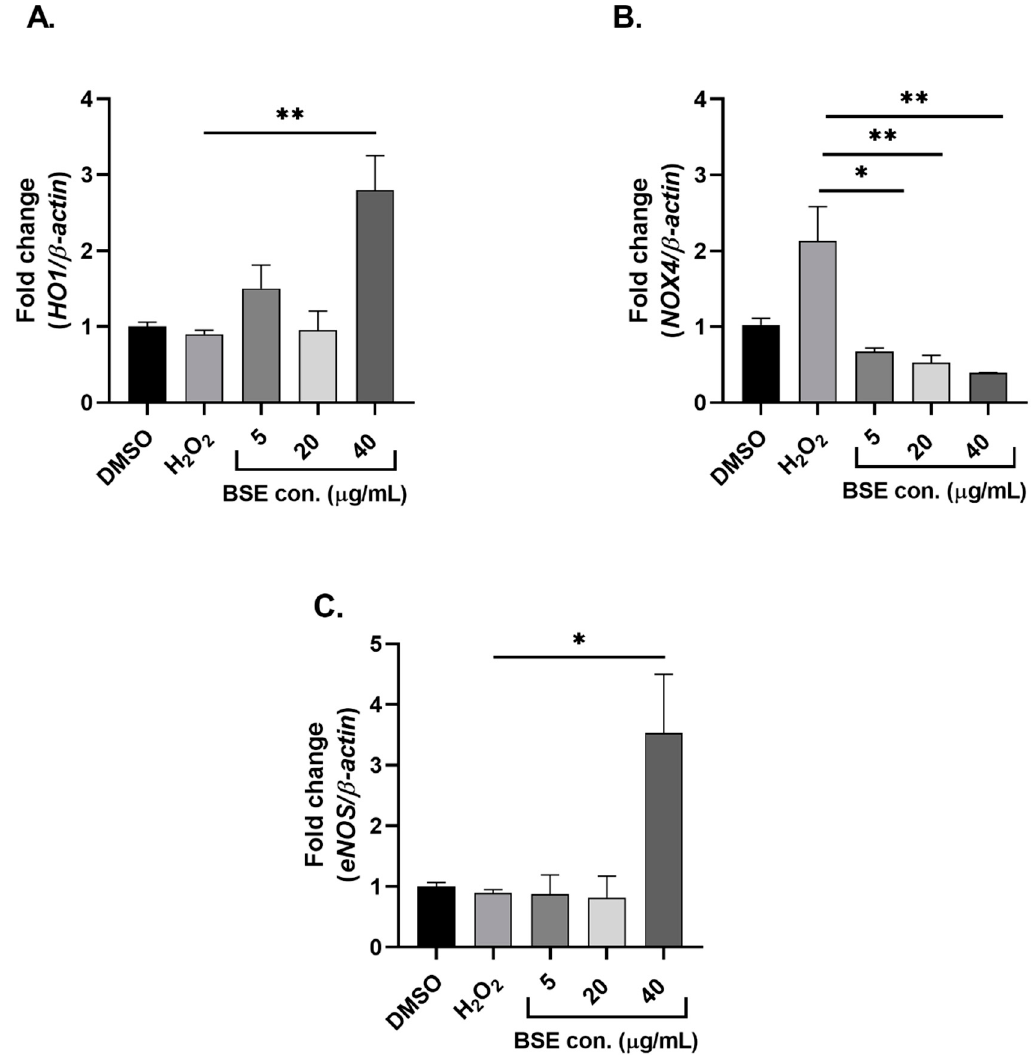
Figure 2. Changes in the expression profile of antioxidant genes [ HO1 ( A ), NOX4 ( B ) and eNOS ( C )] with BSE pre-treatment on oxidative stress-induced HUVECs. n = 3. Level of significance indicated as * p < 0.05, ** p < 0.01, one-way ANOVA with Tukey’s multiple comparison post hoc test. Data is presented as mean ± SEM. DMSO—Dimethyl sulfoxide, HUVEC—human umbilical vein endothelial cells, BSE—black sorghum extract.